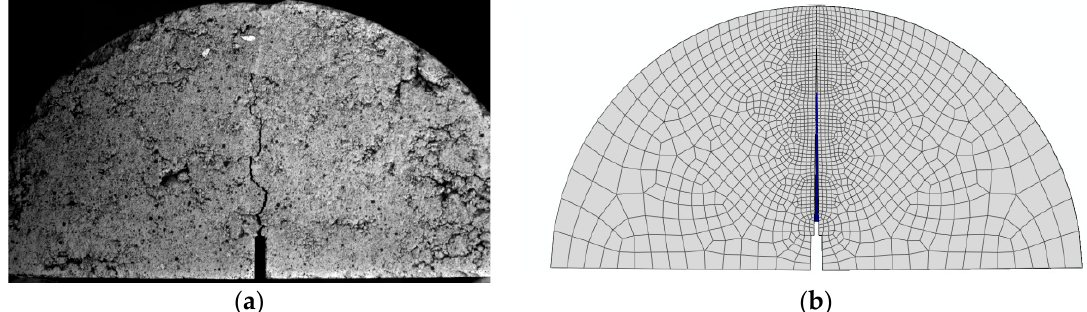
Figure 8. Comparison of cracks between the test and simulation derived from asphalt surface layer at 1 s ( a ) crack in the test, ( b ) crack in the simulation.